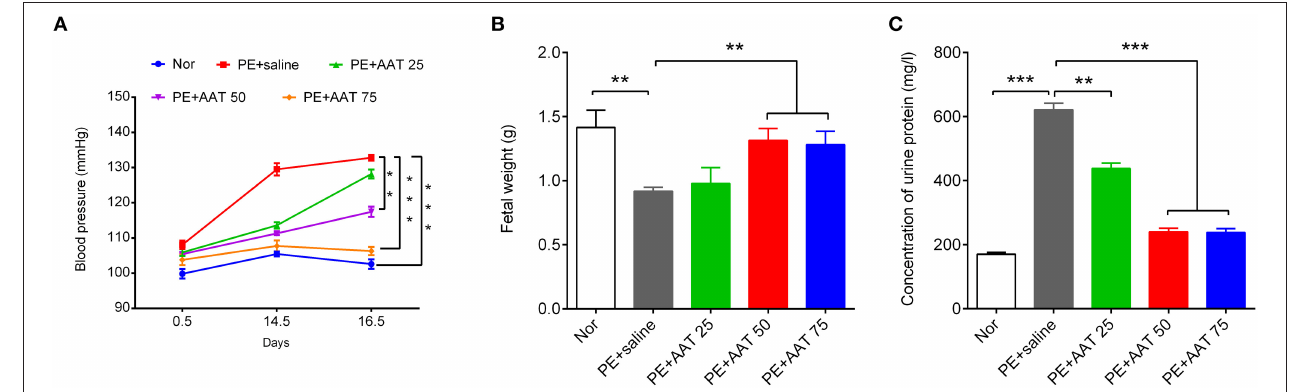
FIGURE 1 | AAT decreases blood pressure and urinary protein levels, and increases fetal weights in PE animal model. (A) Non-invasive rat tail blood pressure detecting method was used to measure blood pressure on days 0.5, 14.5, and 16.5; the measurement was repeated at least three times. (B) The fetuses were obtained to evaluate the weights; (C) The proteinuria was measured on day 17.5 of pregnancy. N = 8 . ** p < 0.01 , *** p < 0.001 .